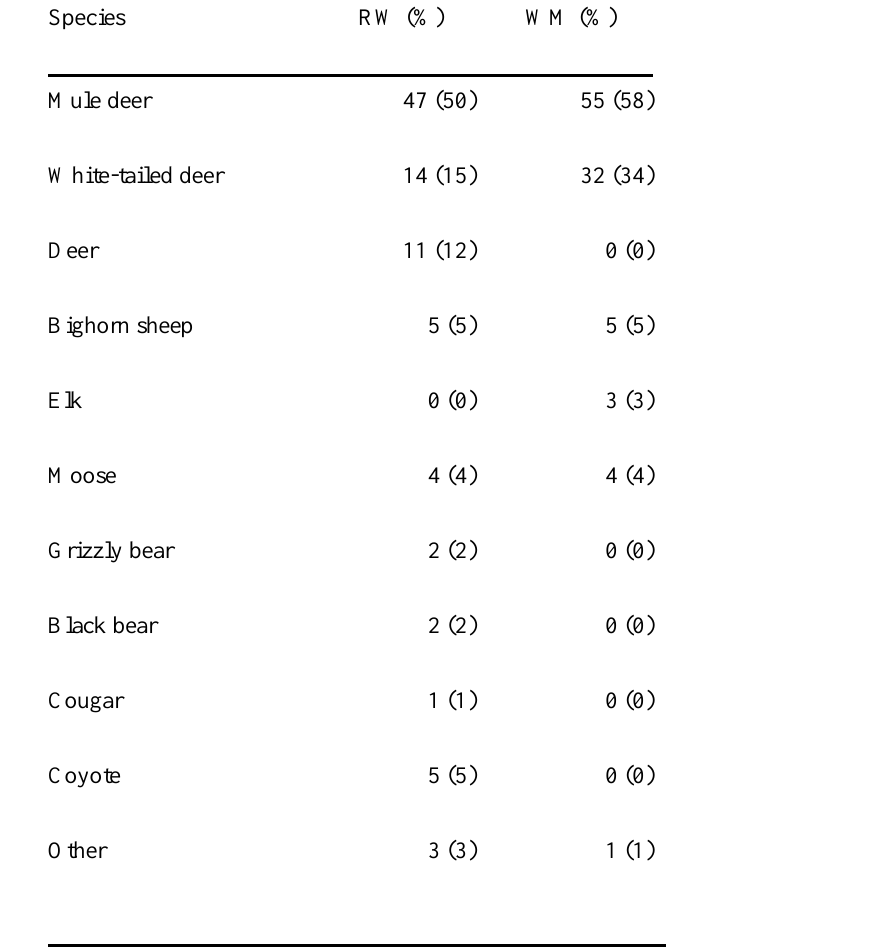
Table 1. Species compositions of Road Watch (RW) and wildlife mortality (WM)